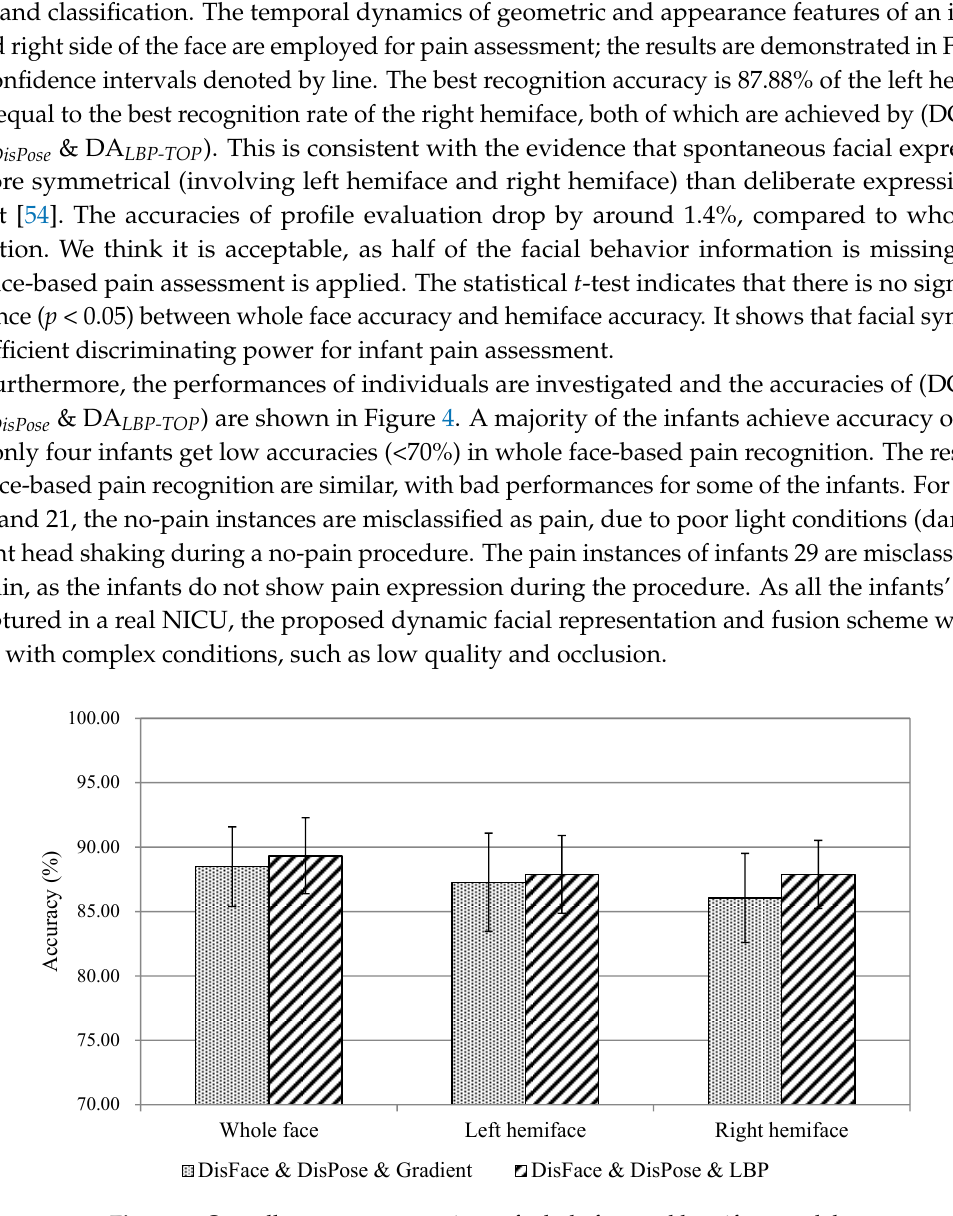
Figure 3. Overall accuracy comparison of whole face and hemiface model.